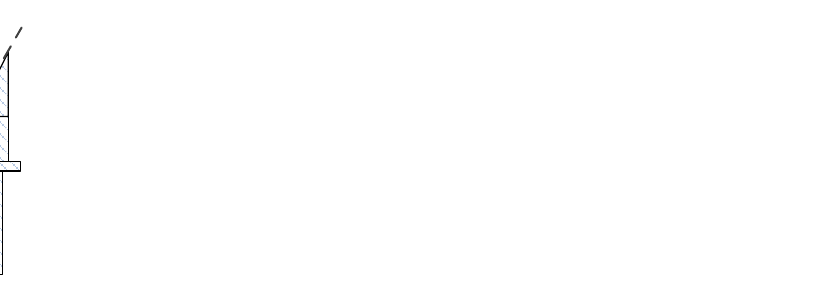
Table 4. Estimation of maximum count rate for high-energy proton probes.